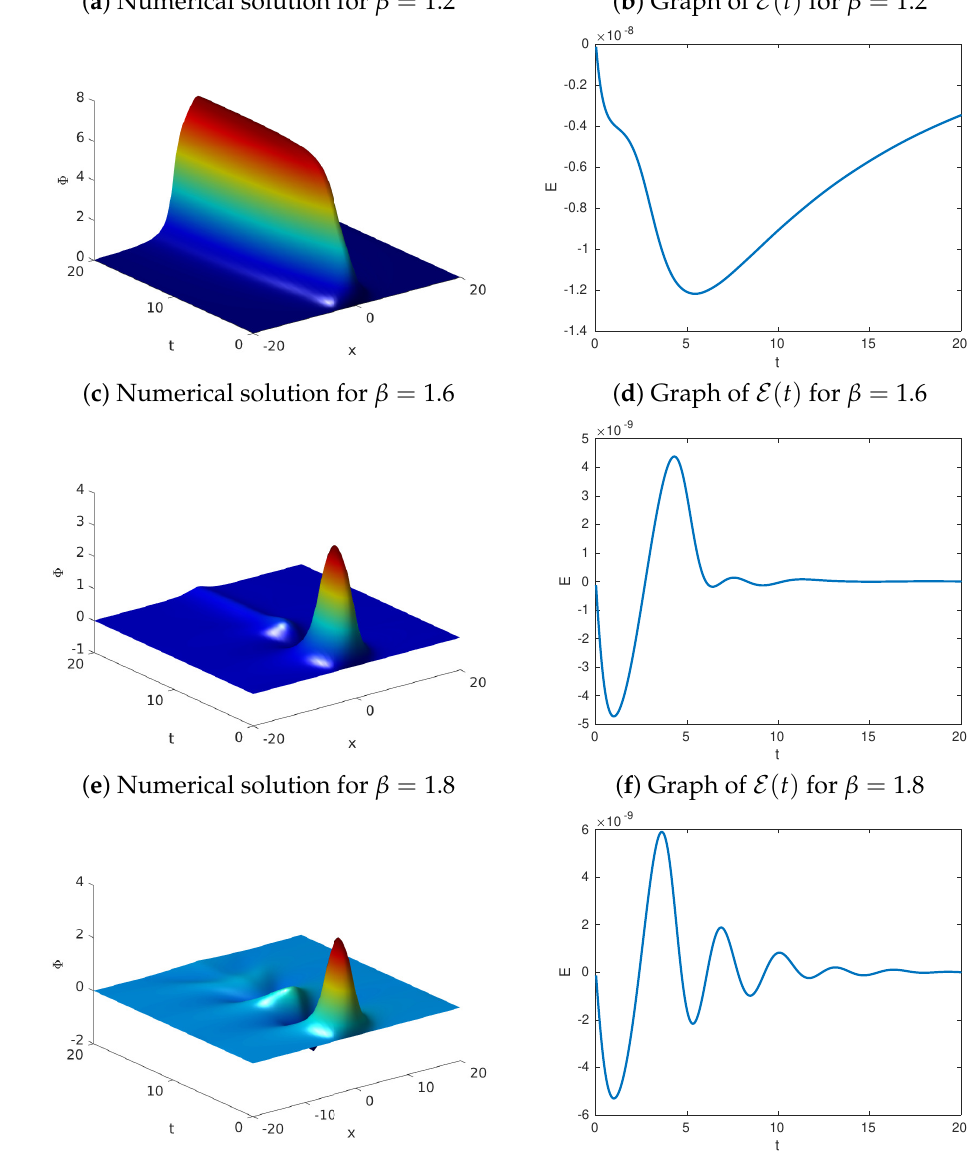
Figure 4. Left column: graphs of the numerical solution for the mathematical model (13). Right column: graphs of the approximate dynamics for the associated functional E . The parameters employed were α = 1.2, γ = 0 and F ( u ) = 1 − cos ( u ) , for each u ∈ R . Moreover, we used β = 1.2 (top row), β = 1.6 (middle row) and β = 1.8 (bottom row). We employed the finite-difference method (42) with Ω = ( − 20,20 ) and T = 20. Computationally, we let h = 0.5 and τ =